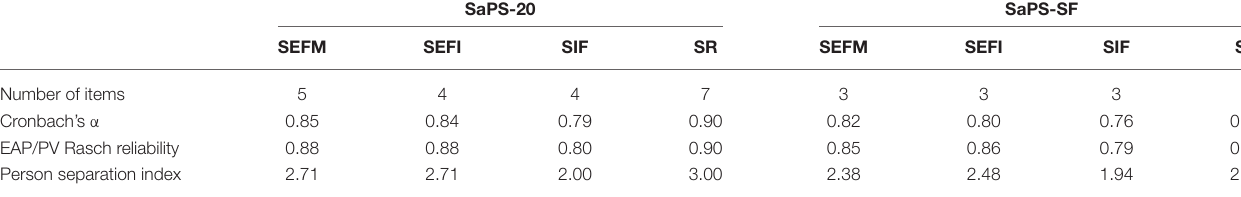
TABLE 5 | Comparison of reliabilities of the SaPS-20 and SaPS-SF.